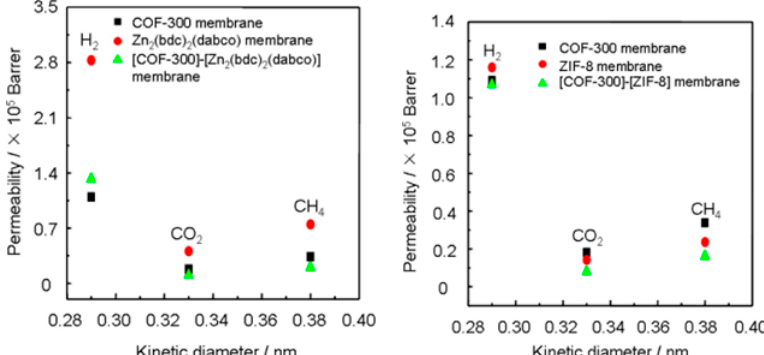
Figure 44. ( left ) Single gas permeability of various gases through the COF-300 membrane, Zn 2 (bdc) 2 (dabco) membrane, and [COF-300]-[Zn 2 (bdc) 2 (dabco)] composite membrane at room temperature and 1 bar as a function of their kinetic diameters. ( right ) Single gas permeability of various gases through the COF-300 membrane, ZIF-8 membrane, and [COF-300]-[ZIF-8] composite membrane at room temperature and 1 bar as a function of their kinetic diameters. (adapted with permission from ref. [137]).